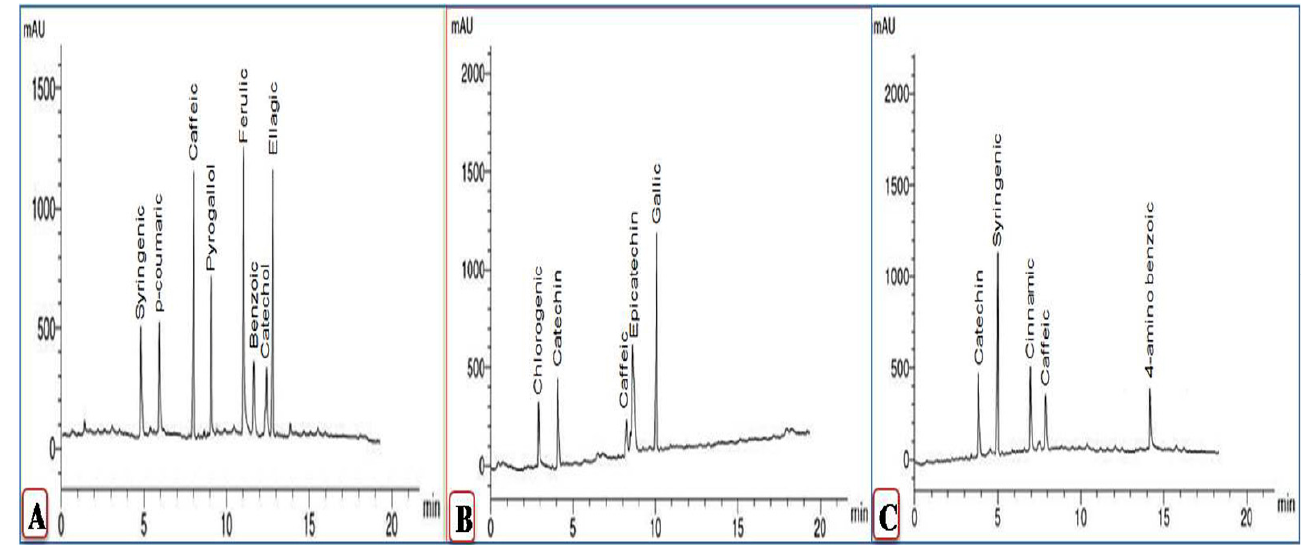
Figure 4. HPLC chromatograms of phenolic compounds in ethanolic extract of the squash plant. Mock-inoculated plants ( A ), CMV-inoculated plants at 6 dpi ( B ), and CMV-inoculated plants at 12 dpi ( C ).